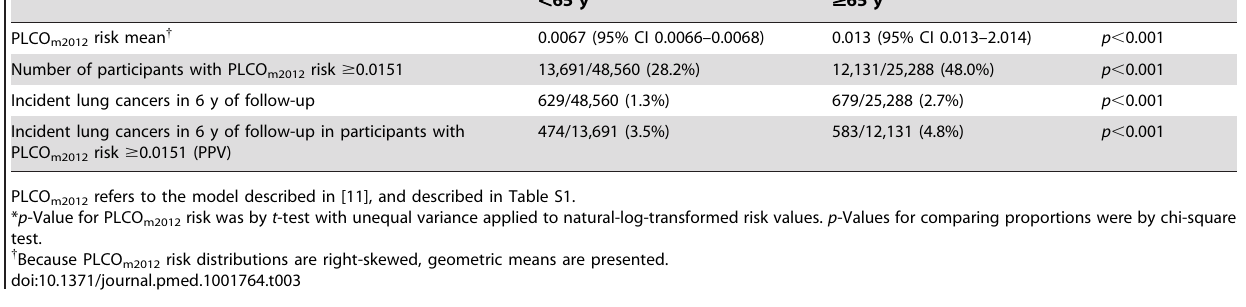
Table 3. Comparison of PLCO m2012 risk and incident lung cancer in age strata of PLCO smokers dichotomized at age 65 y.